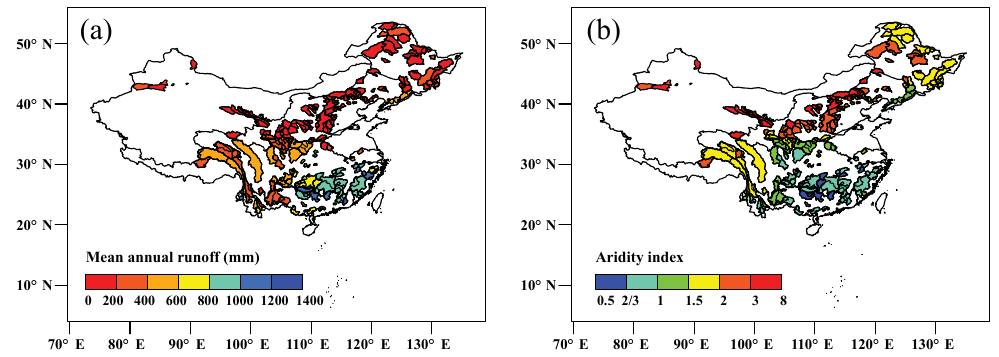
Figure 2. Spatial distribution of (a) mean annual runoff and (b) aridity index ϕ in the 291 study catchments.